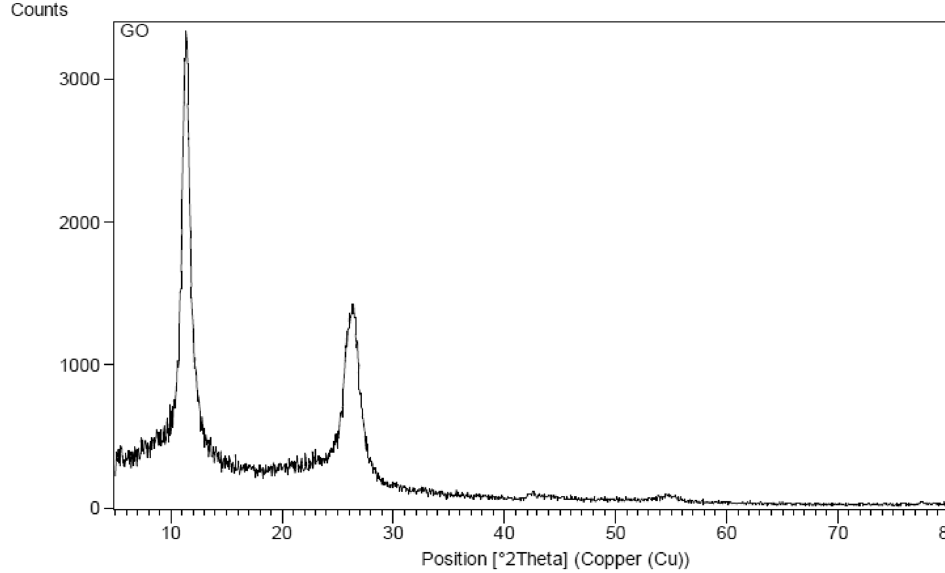
Figure 2. XRD patterns for the synthesized graphene oxide.